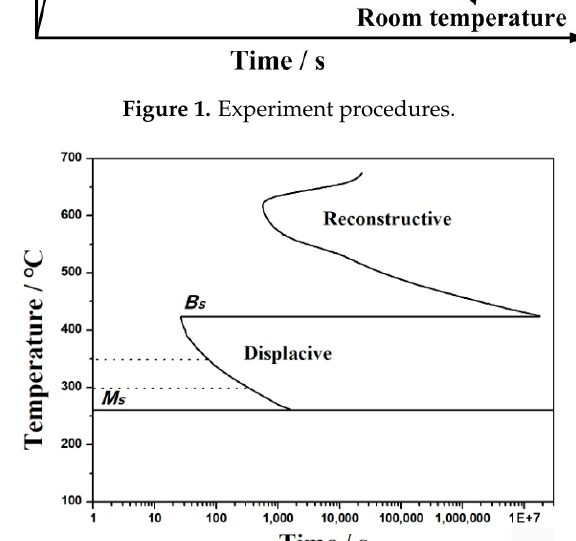
Figure 2. The time temperature transformation diagrams of tested steel.